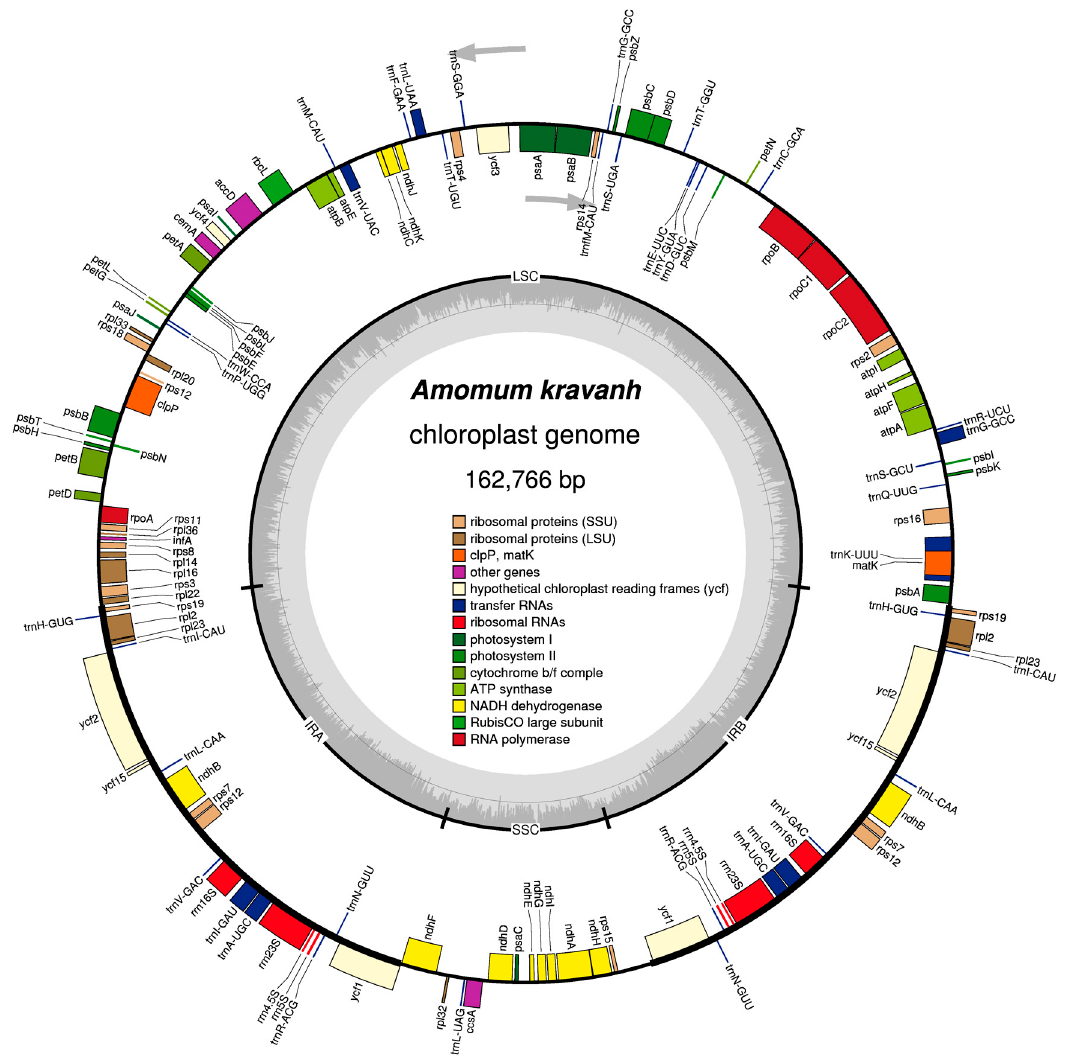
Figure 1. Map of the A. kravanh cp genome map. Genes drawn inside the circle are transcribed clockwise, and those outside are counterclockwise. Genes belonging to different functional groups are color-coded. The darker gray in the inner circle corresponds to GC content, while the lighter gray corresponds to AT content.